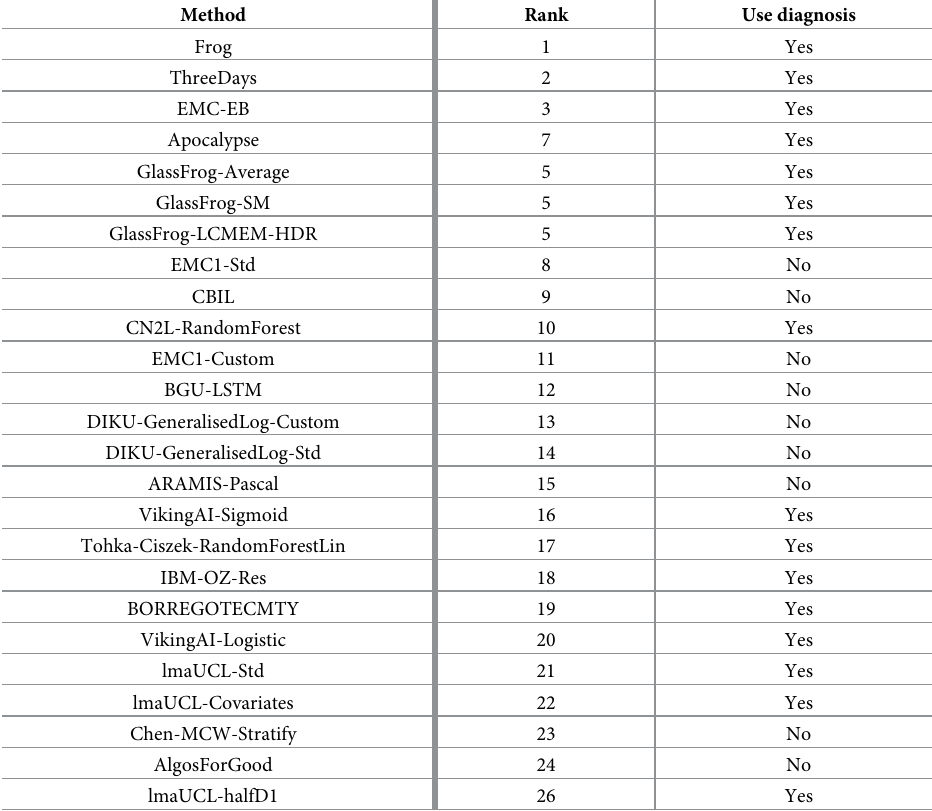
Table 4. TADPOLE Challenge top 25 methods and use of